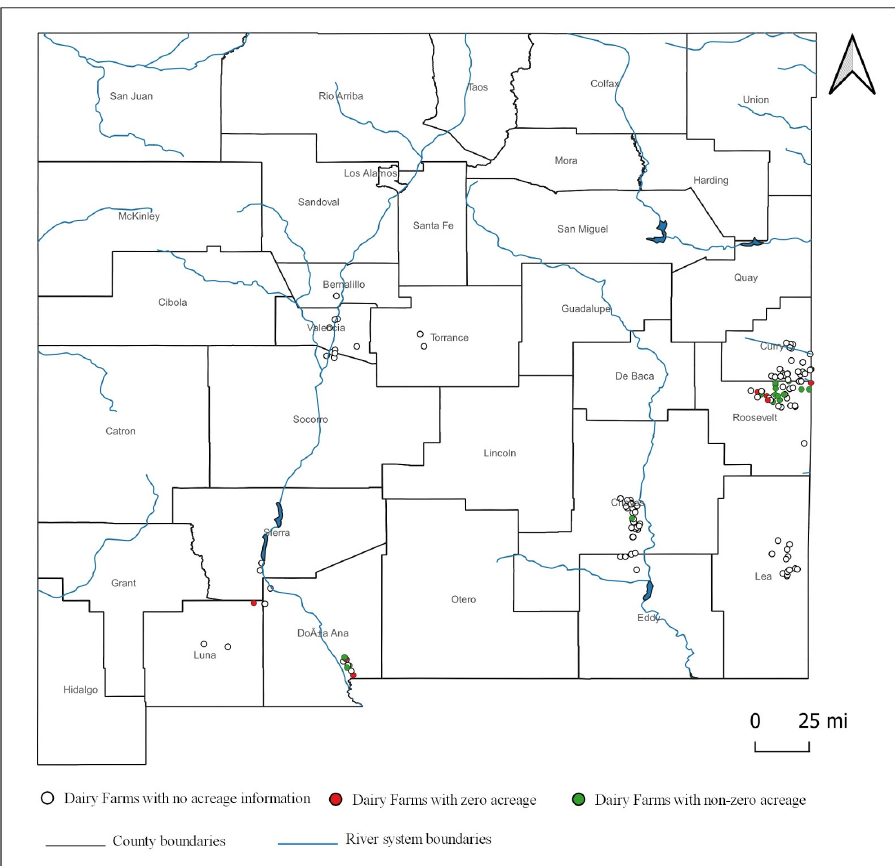
Figure 1. Dairy farms in New Mexico, US. The acreage data for different types of crops and grasslands were obtained from the land use land cover (LULC) data from the United States Department of Agriculture, which depict agricultural land cover at a 30 m resolution. The LULC data consist of a geo-refer- enced raster image with crop-specific categories and estimated acreages embedded. The data were analyzed using the software QGIS to calculate the acreages for each LULC cat- egory at different scales. The total area of New Mexico is more than 31.5 million hectares, out of which almost 2.1% or about 0.66 million hectares (fallow land included) was used as cropland in 2019. The selected single and double field crops in our study comprise more than two-thirds or about 0.45 million hectares of the croplands excluding fallow land. This number can vary year to year and is likely even greater as most of the fallow land is occu- pied by the field crops. Grasslands or pasture occupy almost ten times the acreages of field crops with a total of 4.65 million hectares. Shrublands constitute a major portion of the state, occupying about 64% of the land or 20.44 million hectares. The developed area which includes all the residential areas, industries, and other artificial structures com- prises a tiny fraction of the land with about 386,880 hectares. Figure 2 displays the spatial pattern of croplands and grasslands in New Mexico.